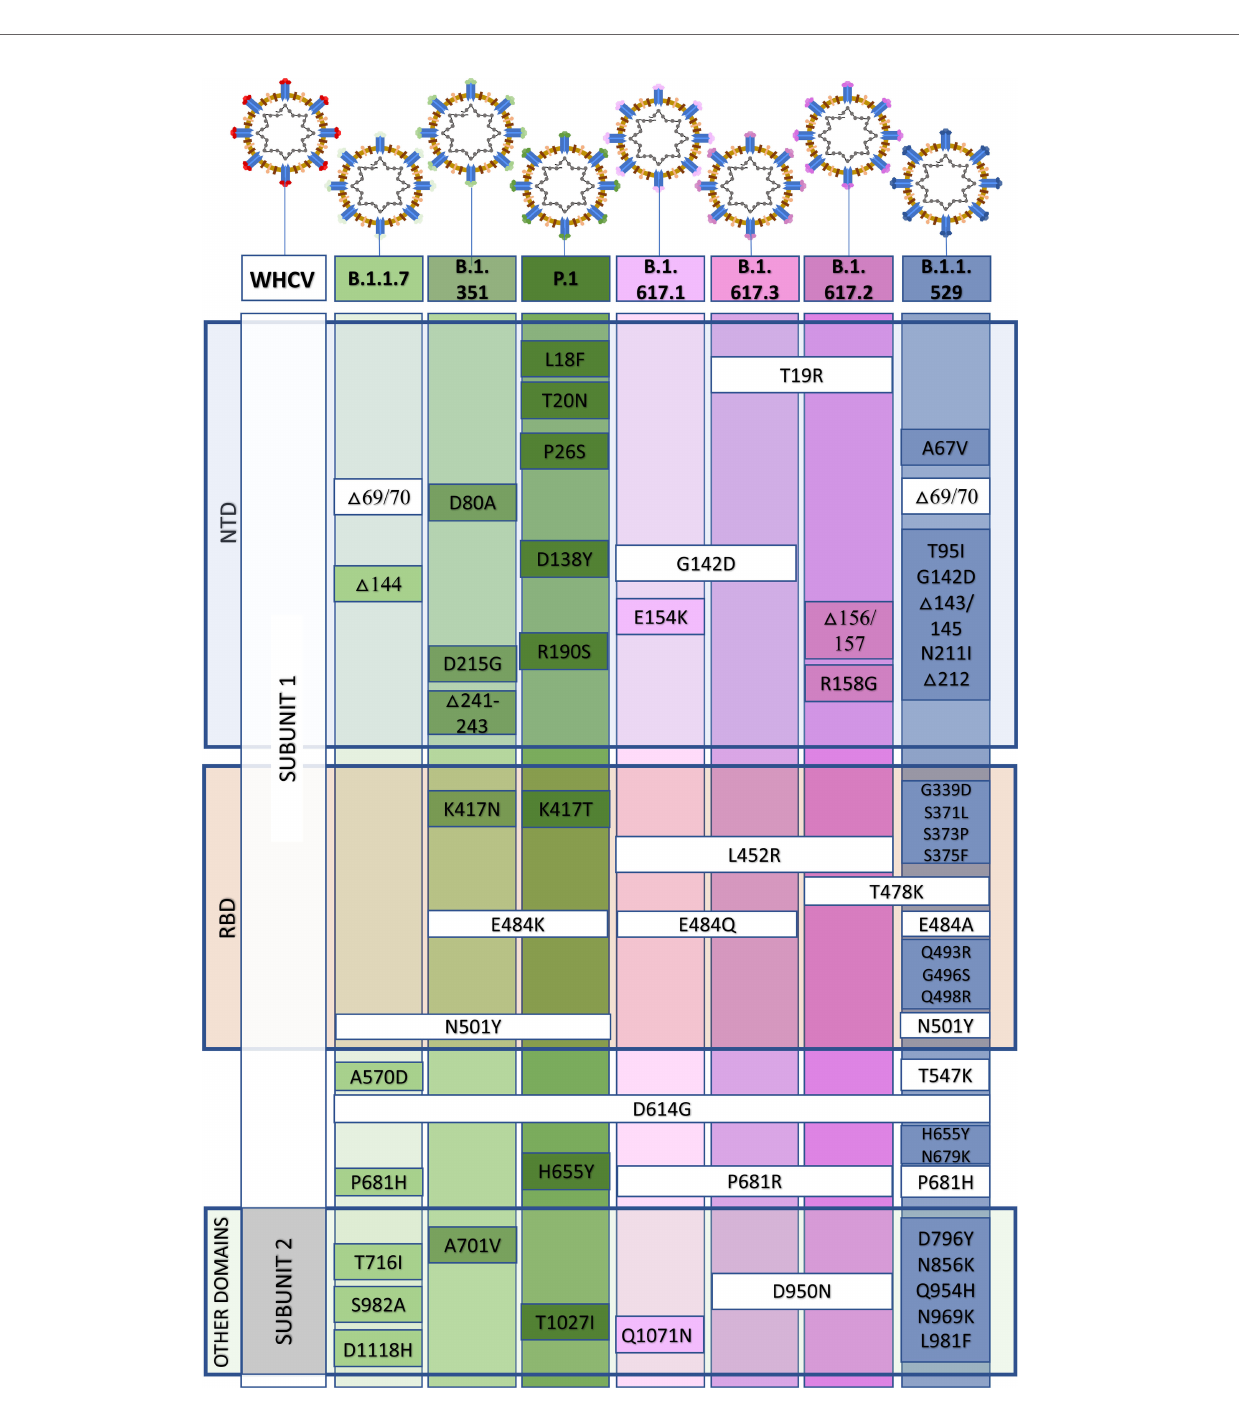
FIGURE 3 | Similar and differential mutations in the spike (S) protein from the B.1.1.7, B.1.351, P.1, B.1.617, and B.1.1.529 variants of concern. NTD, N terminal domain; RBD, receptor-binding